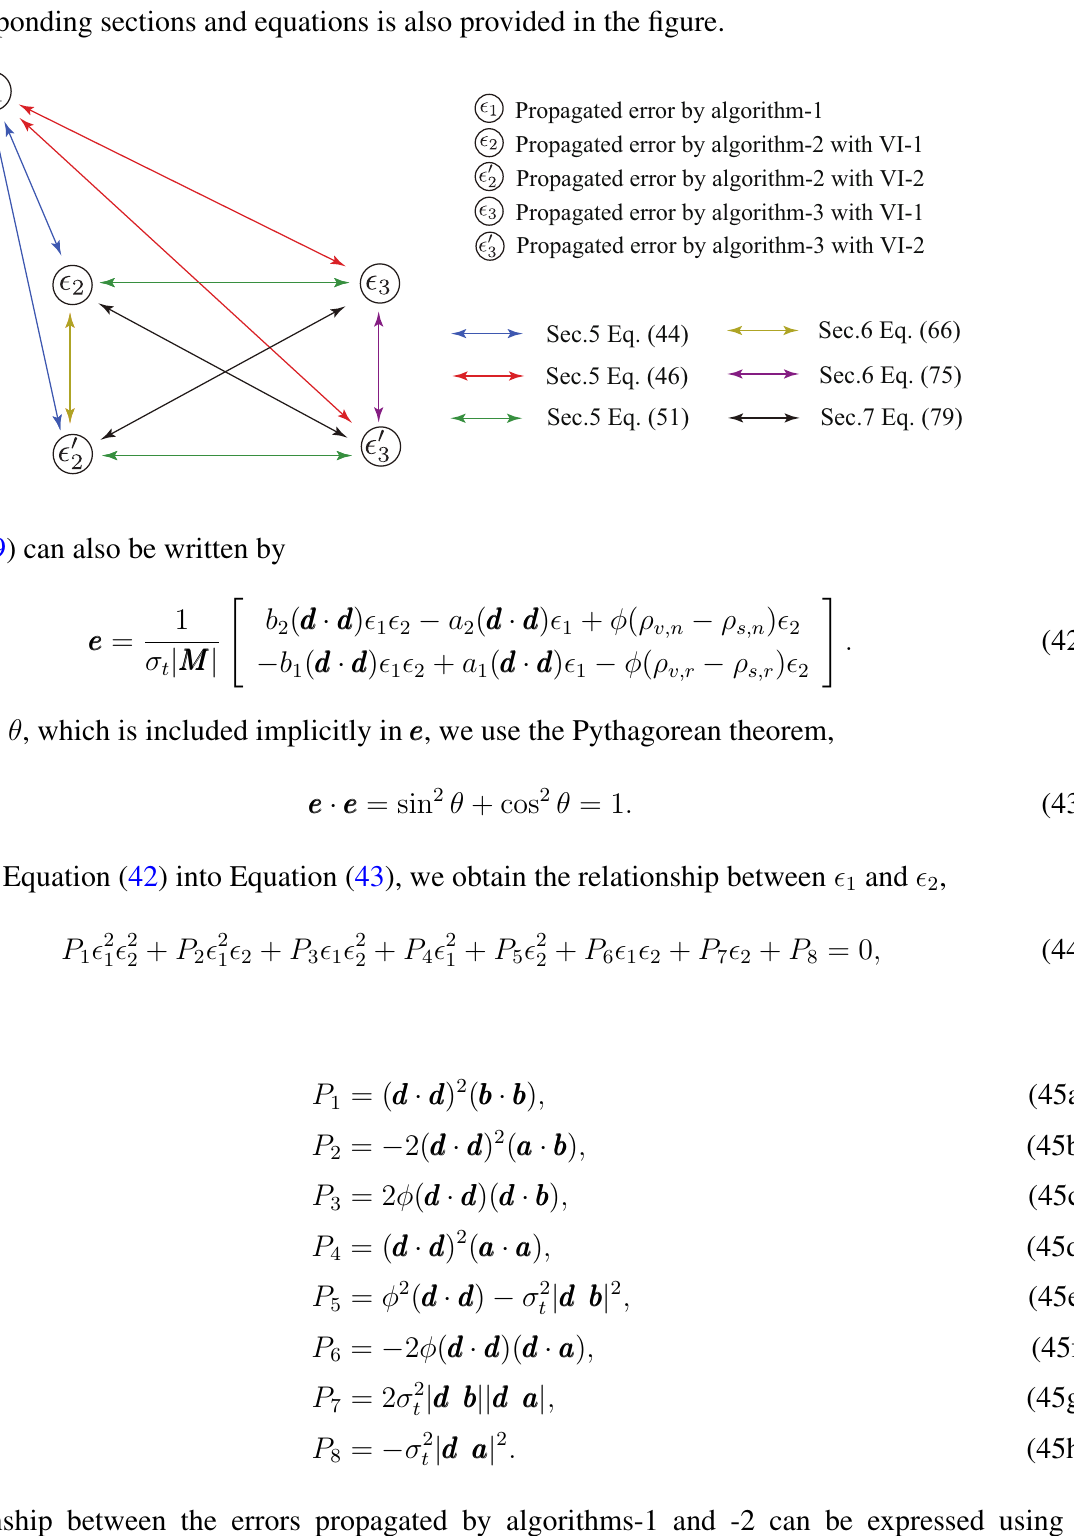
Figure 4 . Schematic diagram describing the relationships among errors propagated in each algorithm considered in this study. The relationships between the errors propagated by each pair of algorithms are indicated by the colored bidirectional arrows. Information about the corresponding sections and equations is also provided in the figure.